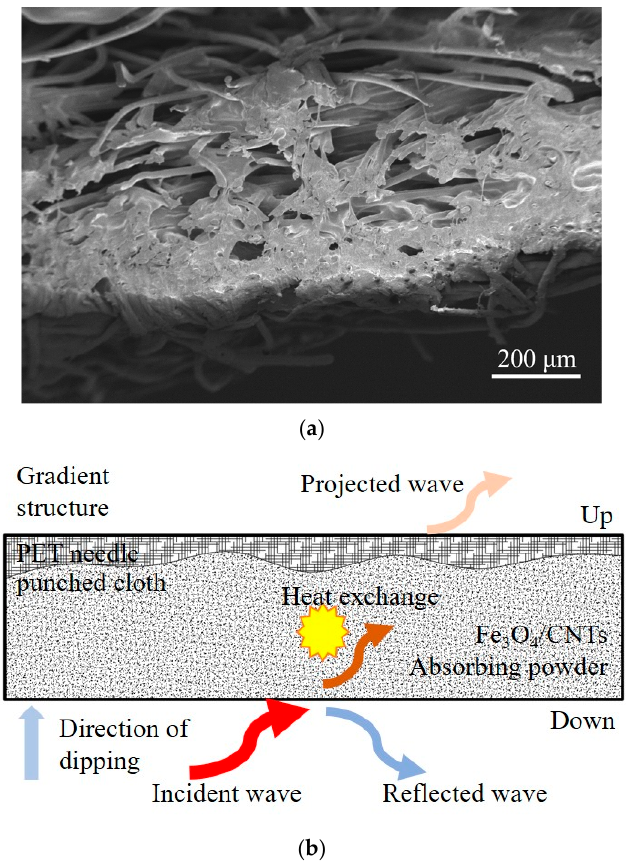
Figure 8. Structure and principle of PU/PET matrix microwave-absorbing gradient composites: ( a ) SEM image of cross-section of PU/PET matrix microwave-absorbing gradient composites (WD = 7.4 mm, EHT = 2.0 kV); ( b ) Principle of PU/PET matrix microwave-absorbing gradient composites.